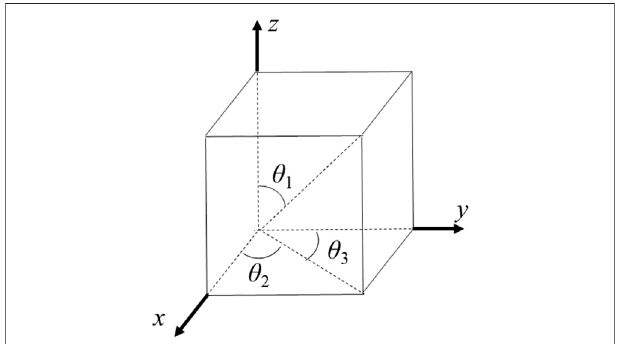
FIGURE 1 | Schematic diagram in the rectangular coordinate system.